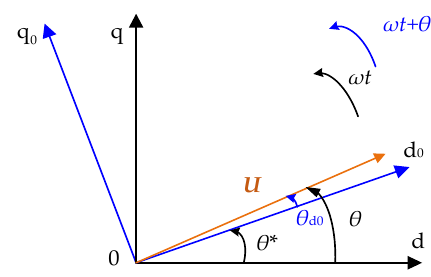
Figure 7. The diagram of the fine-tuning of the rotation angle of dq frame.